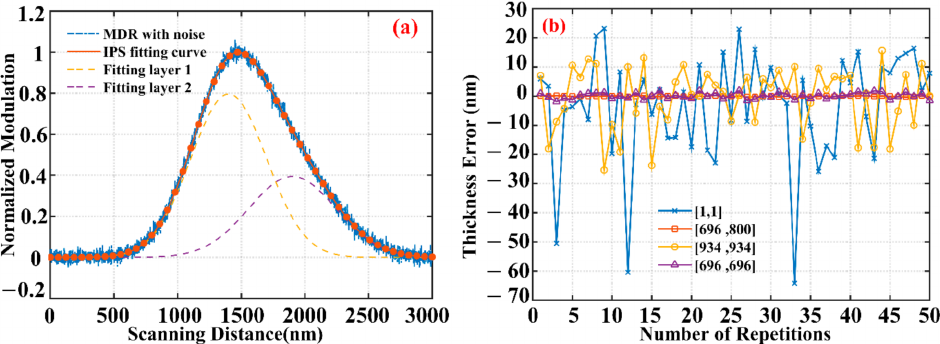
Figure 4. ( a ) The simulated MDR with noise and the fitting result by the IPS-SIM as the initial widths ( F ) = ( 696, 696 ) ( b ) Thickness measurement error of the different initial width 1 ini , F 2 ini